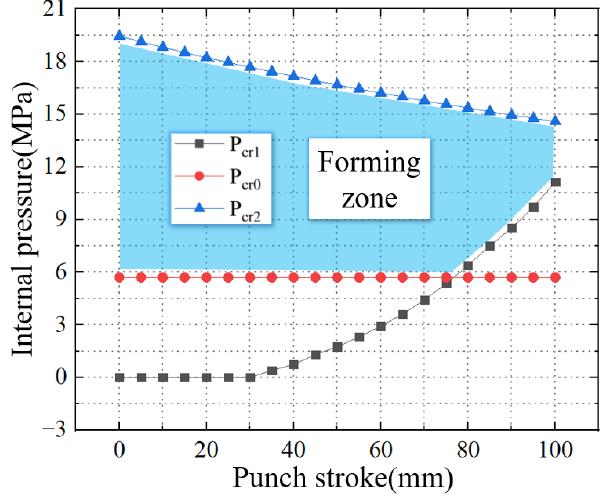
Figure 19. Forming zone of TUBG in this experiment.